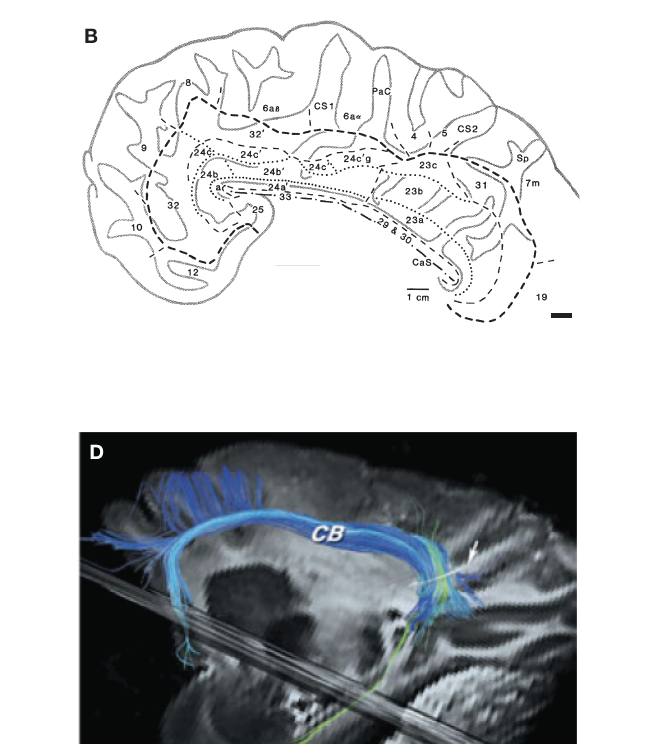
FIGURE 2 | The cingulate cortex and cingulum bundle. (A) Medial surface view of the human brain, depicting the cingulate gyrus (CG) and the cingulate sulcus (CS). (B) Human fl at map of the cingulate cortex and surrounding areas. Note that the anterior cingulate is composed of the subgenual area 25, the paracingulate area 32, and six cytoarchitecturally different subregions of area 24